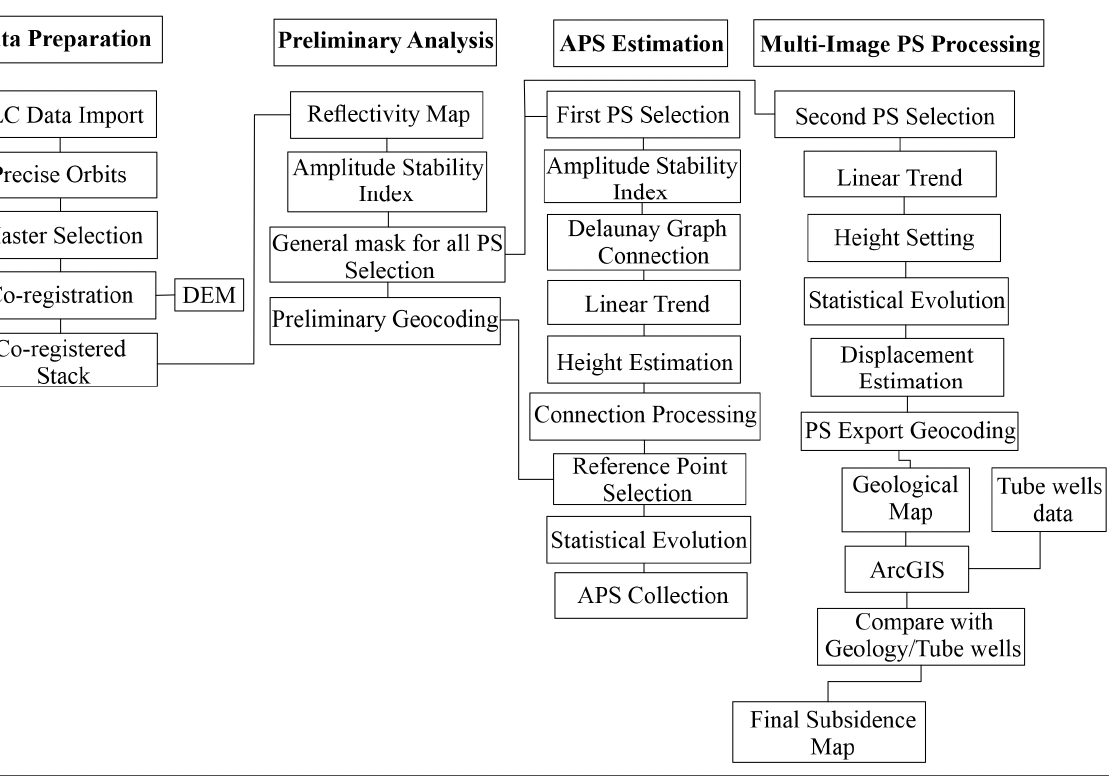
Figure 4. Data processing steps in methodology.